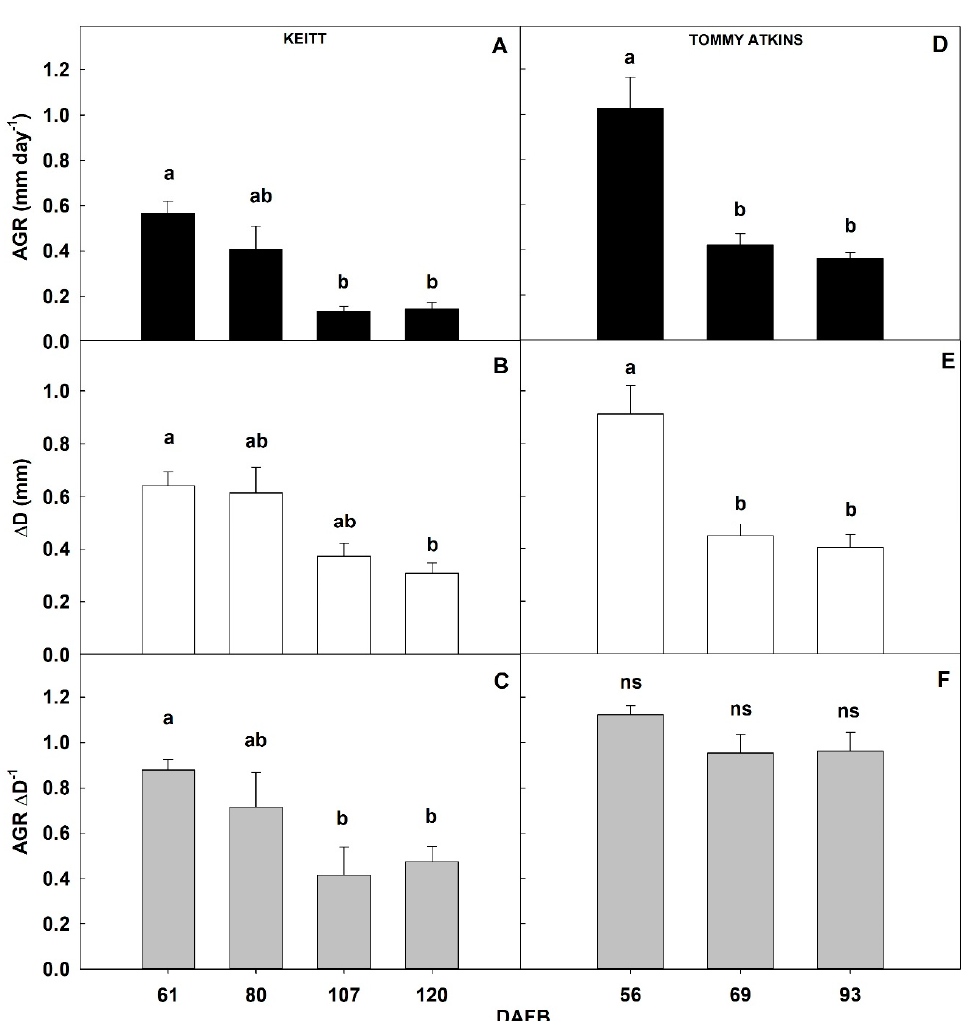
Figure 5. Fruit absolute growth rate (AGR), daily diameter fluctuations ( Δ D), and development index (AGR Δ D − 1 ) of ‘Keitt’ ( A – C ) and ‘Tommy Atkins’ ( D – F ) mango during the monitoring periods (Keitt: 61, 80, 107, 120 DAFB. Tommy Atkins: 56, 69, 93 DAFB). DAFB = days after full bloom.